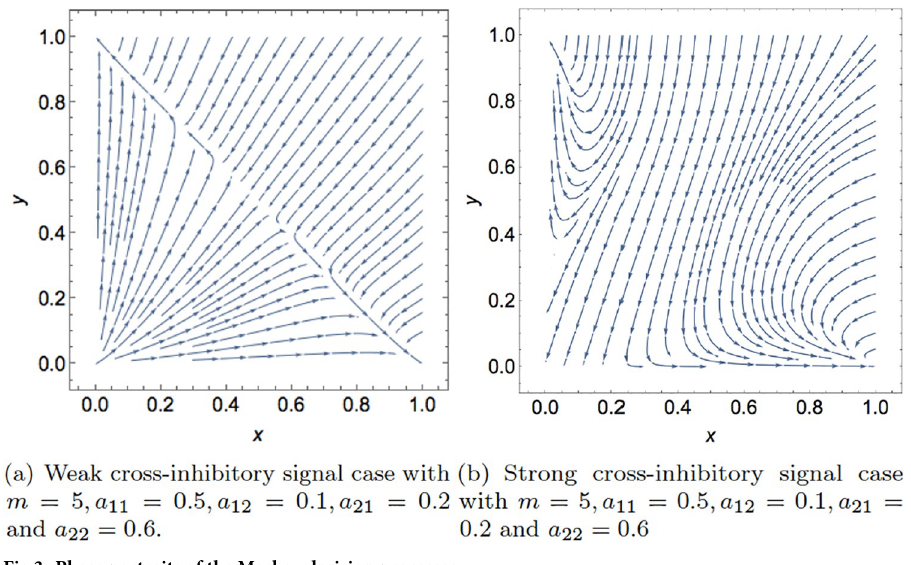
Fig 3. Phase portraits of the Markov decision